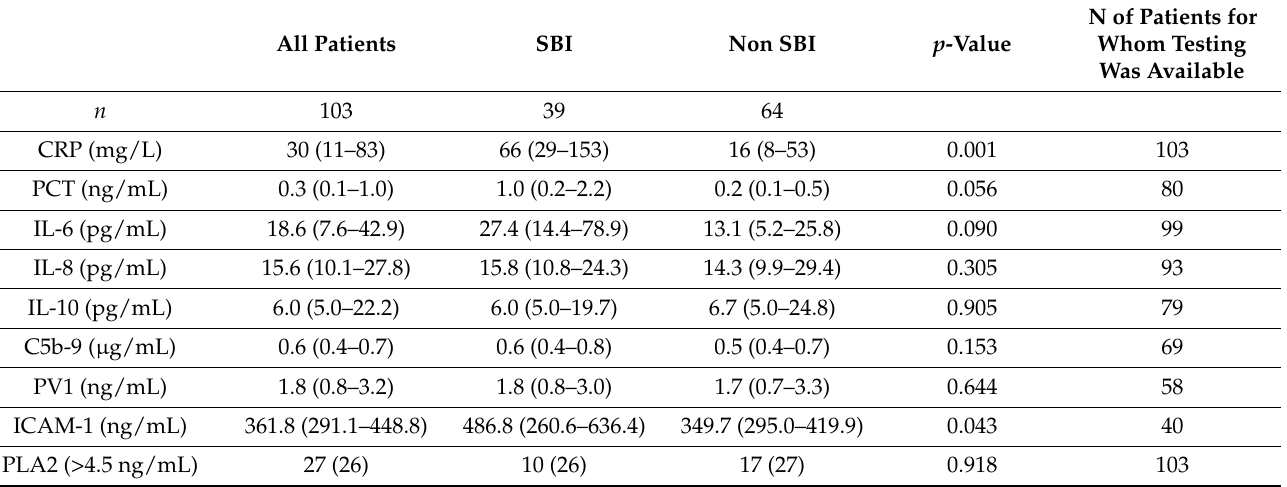
Table 4. Biomarker levels in the studied population.